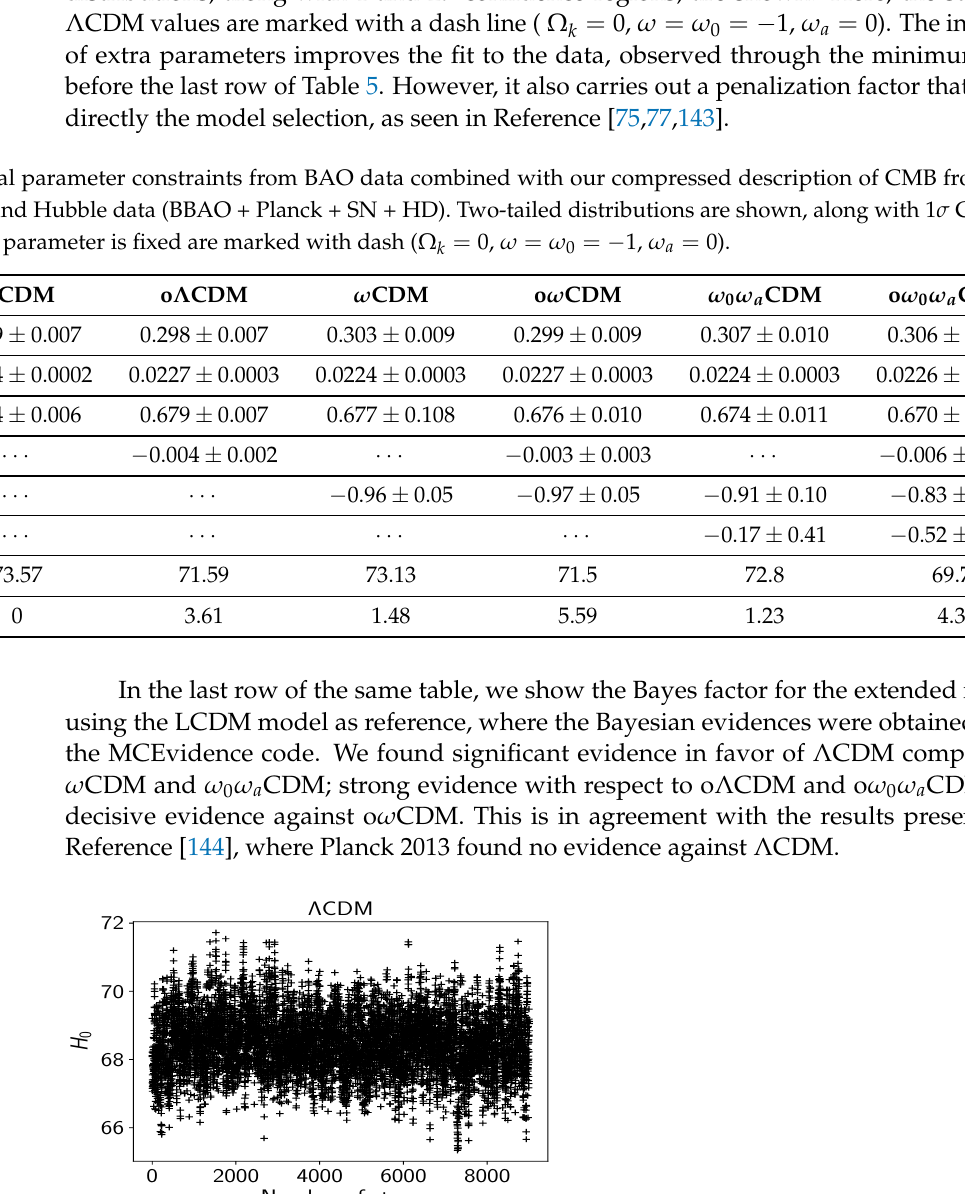
Table 5. Cosmological parameter constraints from BAO data combined with our compressed description of CMB from Planck, the JLA SN, and Hubble data (BBAO + Planck + SN + HD). Two-tailed distributions are shown, along with 1 σ C.L. Entries for which the parameter is fixed are marked with dash ( Ω k = 0, ω = ω 0 =